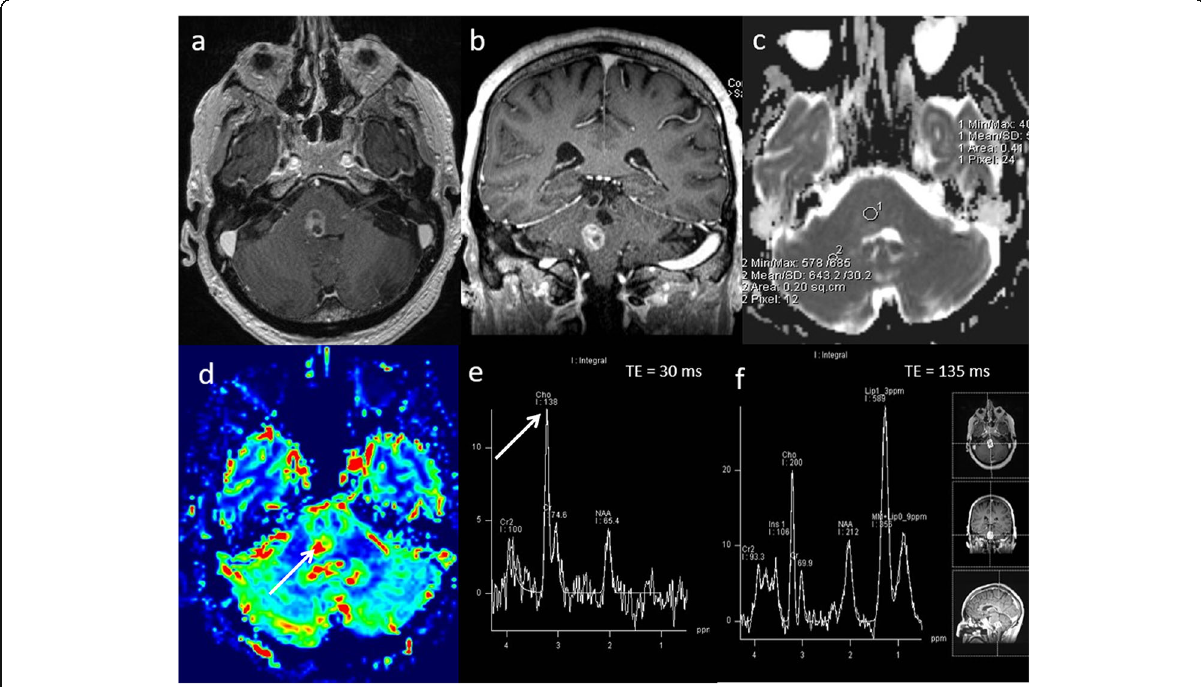
Fig. 6 High-grade glioma. Conventional MRI: a , b Axial and coronal post-contrast T1W sequences, showing a well-defined lesion at the ponto- medullary junction. Multiparametric MRI: c ADC map demonstrates low ADC (590 × 10 − 6 mm 2 s − 1 ). d PWI shows high perfusion (rCBV 2.8, arrow). e , f MRS shows a high Cho/Cr ratio (2.9, arrow), low NAA/Cr ratio and presence of lipid peaks. MRI findings of a low ADC (< 1000 × 10 − 6 mm 2 s − 1 ), high rCBV (> 2) and high Cho/Cr ratio (> 1.8) are consistent with a high-grade glioma rather than a granuloma or abscess. The presence of high choline levels in the perilesional area (not shown) favour high-grade glioma over a metastatic lesion. In this patient, an initial biopsy was inconclusive and as a result of the multiparametric MRI findings, a decision to undergo further biopsy was overturned. The patient